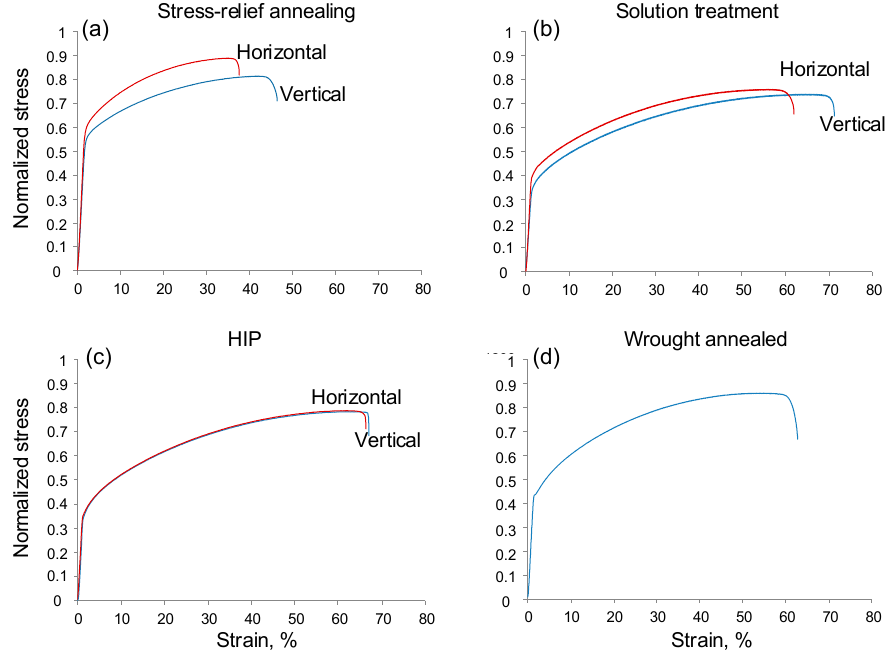
Figure 4. Tensile stress–strain diagrams (RT) of the ( a ) SR-, ( b ) ST-, and ( c ) HIP-treated LPBF alloy and ( d ) wrought annealed alloy.